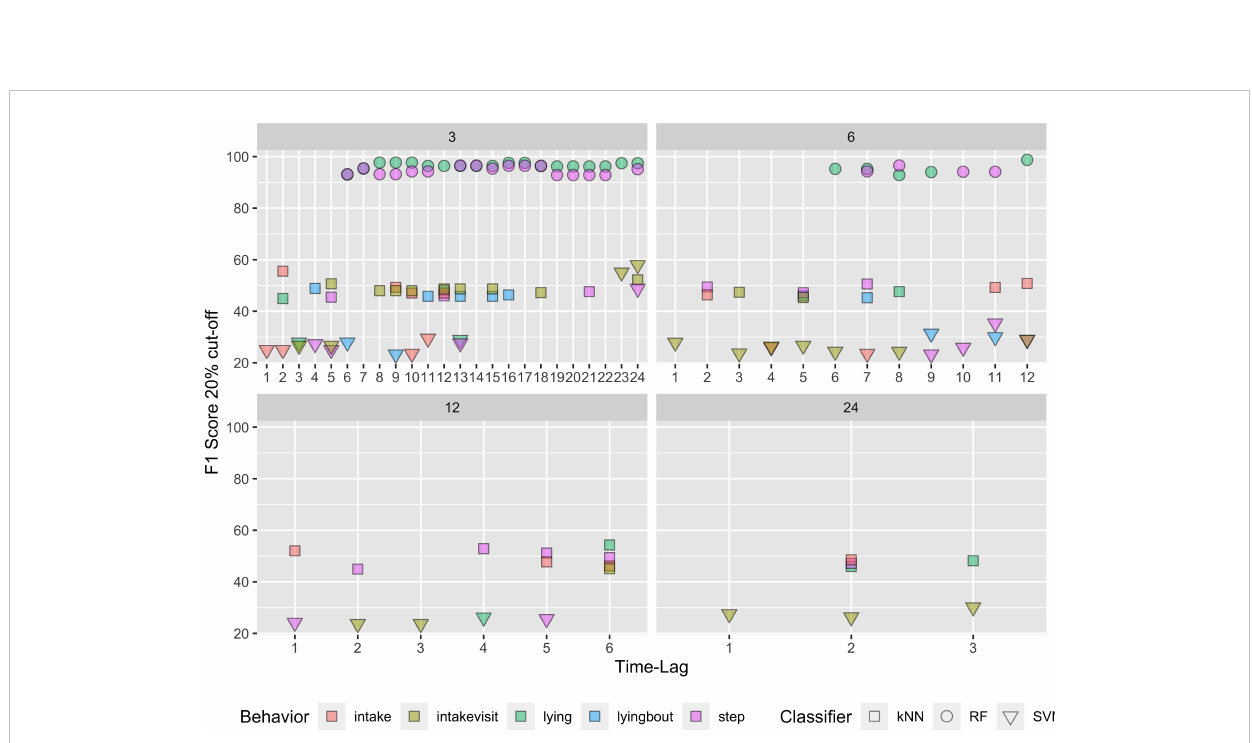
FIGURE 6 Distribution of F 1 scores (%) at the 20% cut-off from the upper quartile by behavior and classi fi er when sensor data registered by a leg-attached 3- axis accelerometer (TrackaCow, ENGS, Hampshire, UK) were aggregated using 24-, 12-, 6-, and 3-hour time windows, and sensor data from all day were used. F 1 scores are shown for different times-lags and for each one of the classi fi ers: k -nearest neighbors (KNN), random forest (RF), and support vector machine (SV).